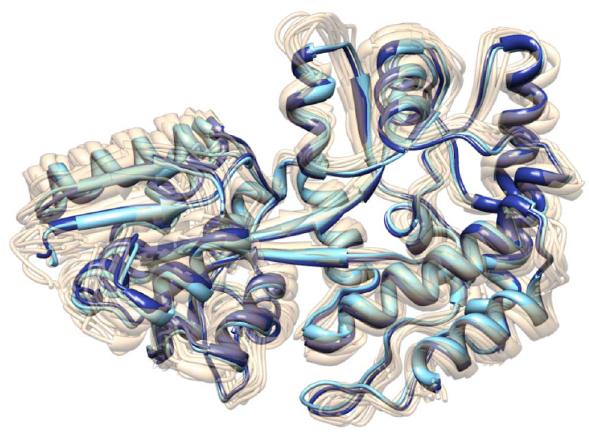
Figure 8. Comparison of a computationally identified interme- diate state and NMR structure PDB :2H25. The identified intermediate state (dark blue) corresponds to the centroid of the low energy region shown in Figure 7. The NMR structure is known to be close to the semi- closed conformation of MBP , showing excellent agreement at the resolution of the ensemble. The closest state along a direct transition between known open and bound forms (aqua structure) of MBP to PDB :2H25 shows almost perfect agreement with the centroid